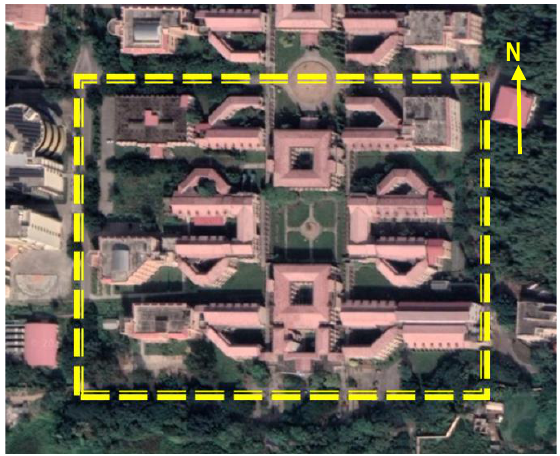
Figure 1. Google image of study